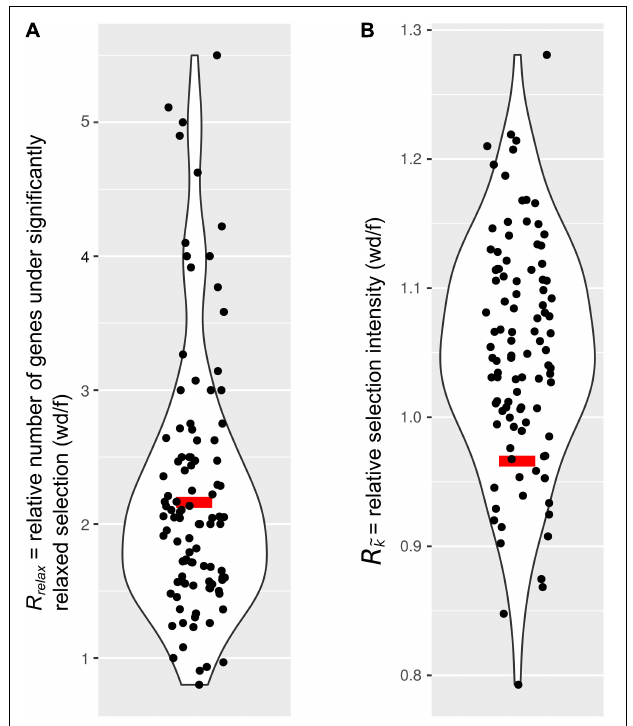
FIGURE 2 | Comparison of selection on immune genes to sets of genes that represent the genomic background. Relaxed selection on IGs does not differ from the genomic background. Red bar, immune genes (IGs); black dots, 100 sets of background genes (BGs). Curves represent smoothed point density. (A) The ratio of the number of genes under significantly relaxed selection between wood-dwellers and foragers ( R relax ). (B) The relative intensity of selection ( R k ) as measured by the ratio of median k ( ˜ k ) between wood-dwellers and